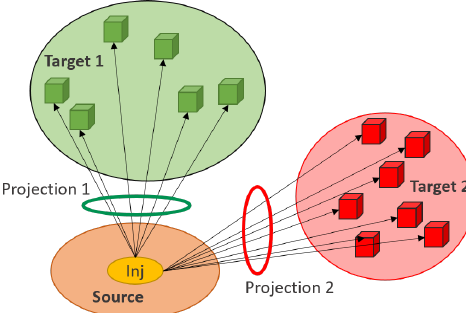
Figure 4. Schematic diagram of Source-Targets projections. A Source is a brain region where the viral tracer is injected (inj, in the figure). As a result of the injection, multiple axonal projections are produced in so-called Target